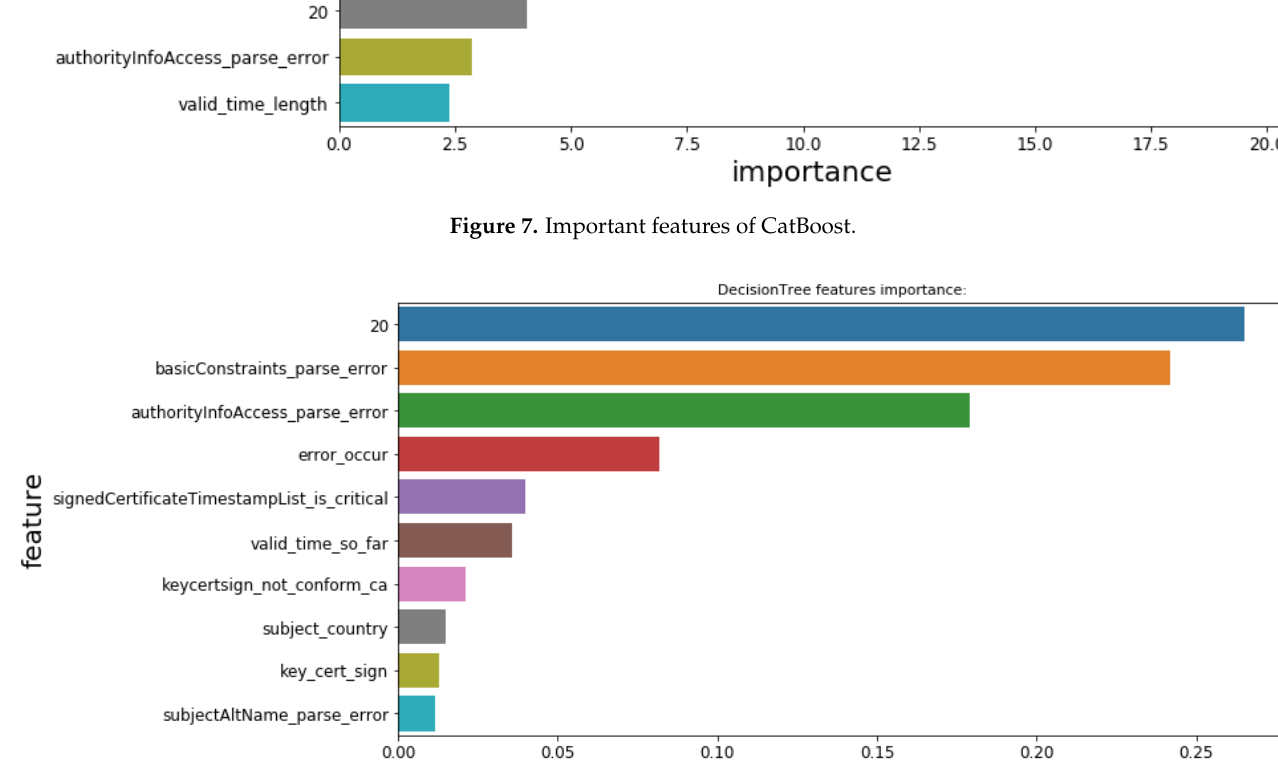
Figure 8. Important features of Decision Tree